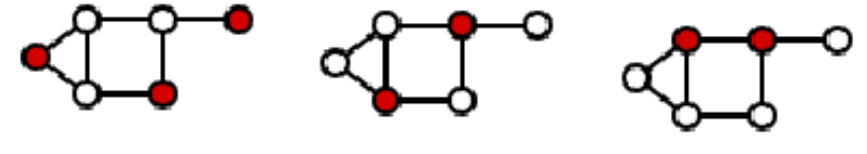
Figure 1. DVS for crisp graph.